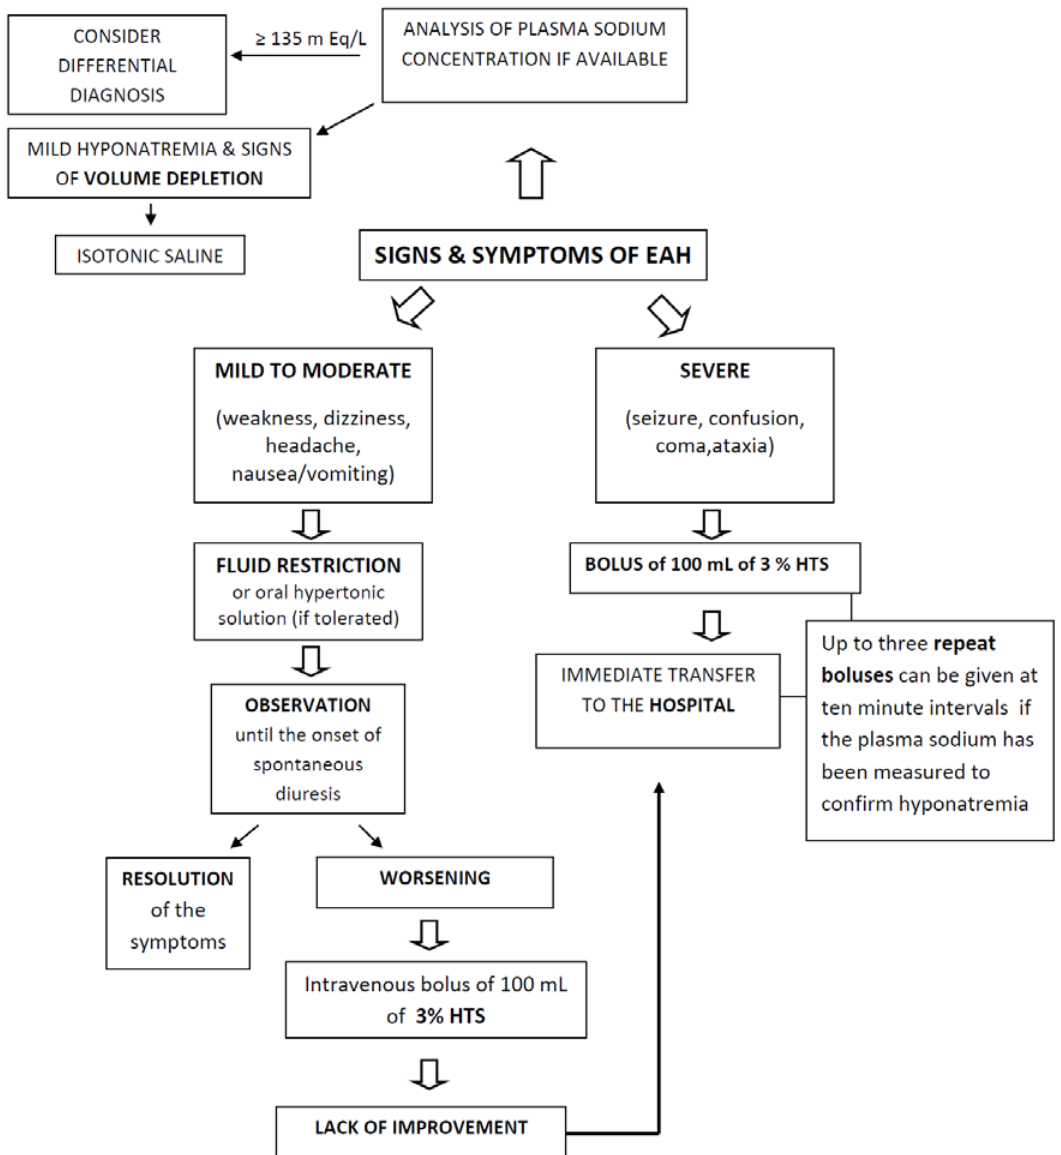
Figure 2. Algorithm for treatment of EAH. EAH, exercise-associated hyponatremia; HTS, hypertonic